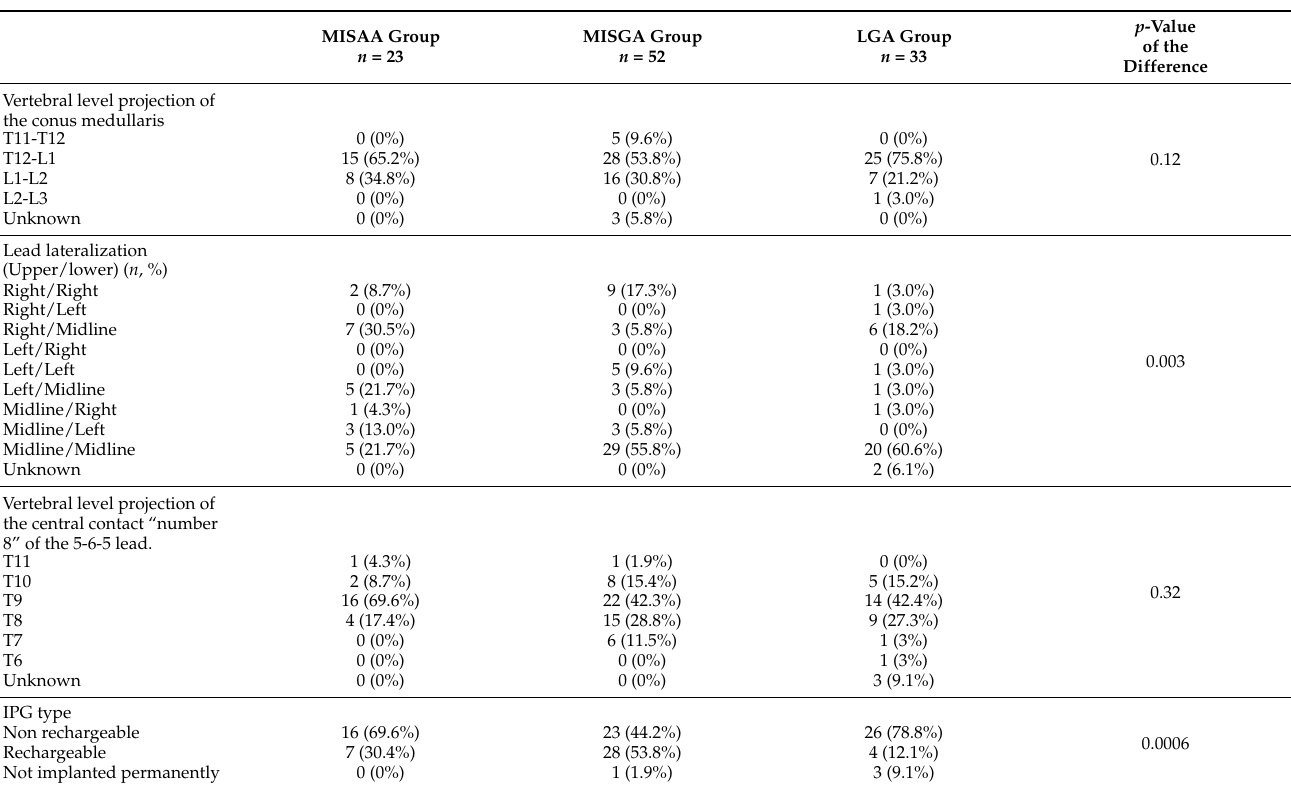
Table 2. Lead implantation parameters and IPG characteristics for each